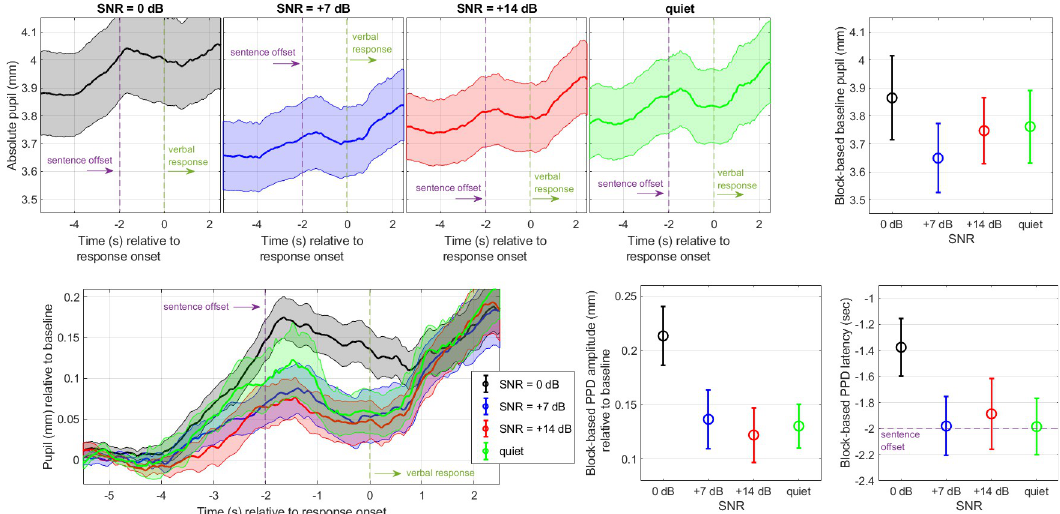
Fig 2. Pupil responses in Experiment 1. Mean pupil traces across four SNR conditions, measured for 21 listeners in Experiment 1. Traces are expressed in absolute unit (top) or relative to the 1-sec baseline (bottom). Three metrics were extracted: Baseline (top- right), PPD amplitude (bottom-middle), and PPD latency (bottom-right). The pupil dilated more at 0 dB than any other SNR. Error bar and shaded width represents 1 standard error from the